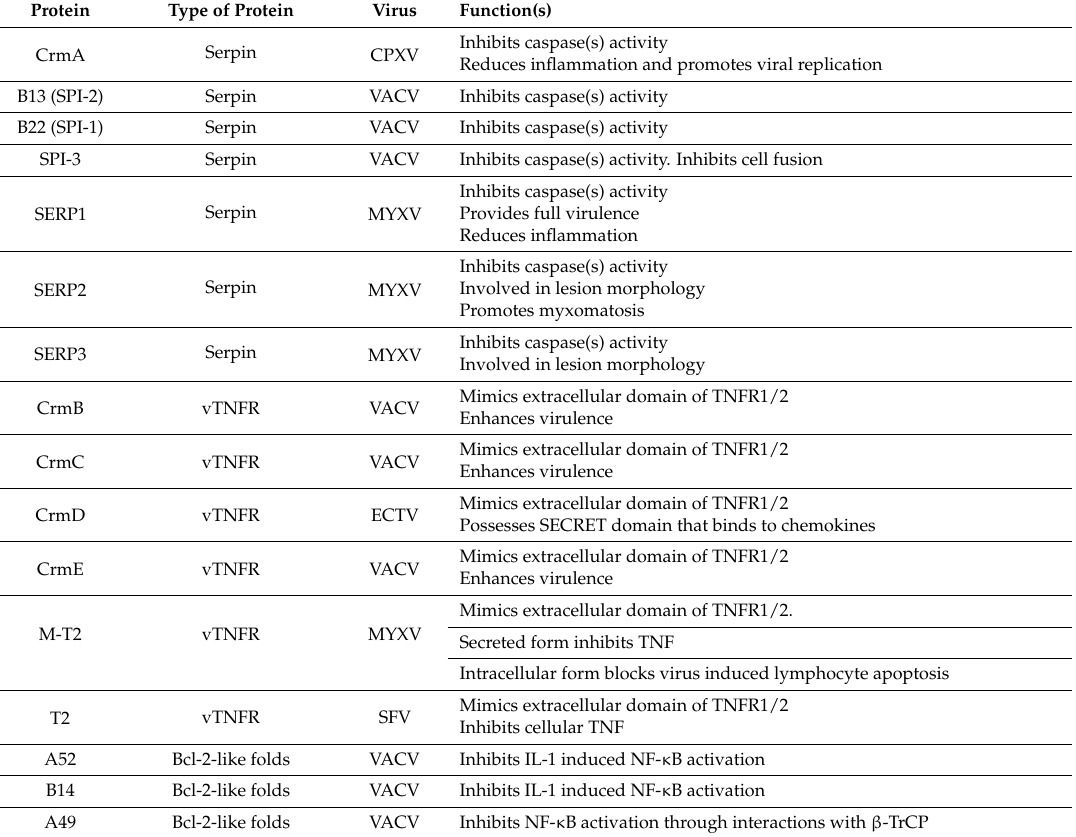
Table 1. Summary of poxvirus products with anti-apoptotic